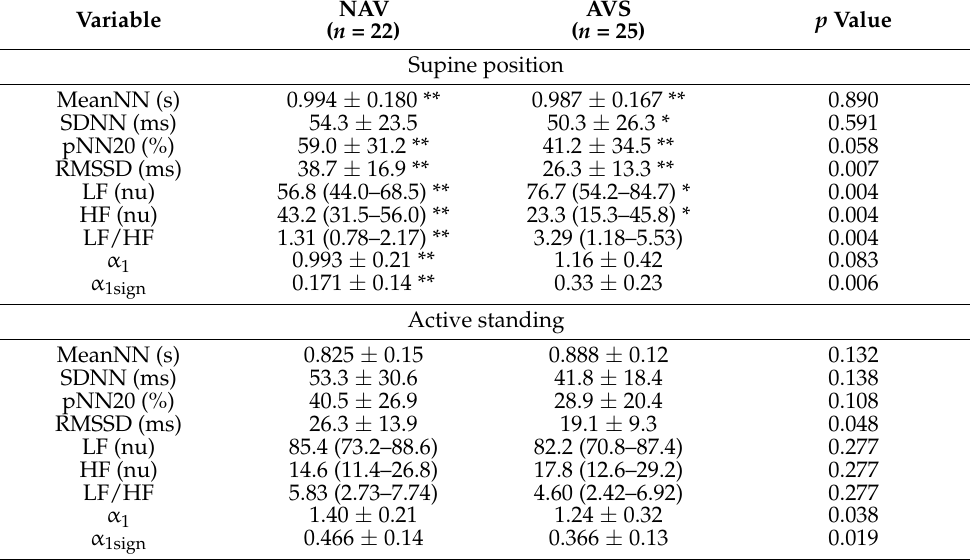
Table 4. Heart rate variability indices at supine position and after active standing. Data are shown as mean ± standard deviation, or median (percentile 25–percentile 75). The groups were compared with analysis of variance for repeated measures or Kruskal–Wallis test, Mann–Whitney U test and Wilcoxon Rank’s test.